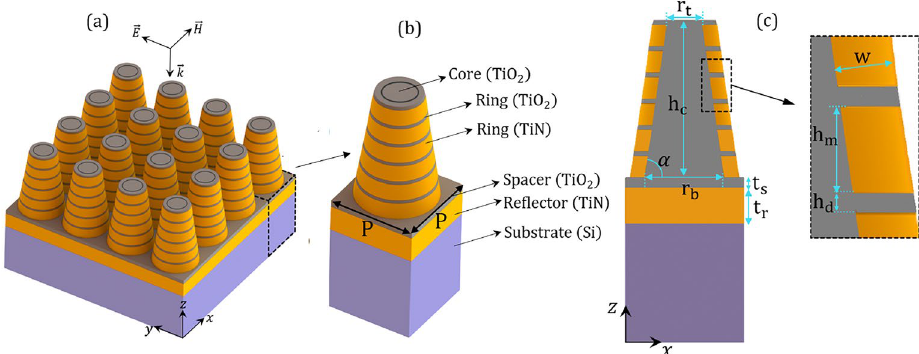
Figure 1. ( a ) Schematic diagram of the proposed metasurface absorber with periodicity P = 500 nm . ( b ) and ( c ) The unit cell and its xz -cross-sectional view. The body of the unit cell is made of a truncated cone-shaped Ti O 2 core of height h c = 660 nm with top and base radii of r t = 101 nm and r b = 200 nm corresponding to the side angle α = 81.47 ◦ . The core is surrounded by conical TiN/Ti O 2 rings of thicknesses W = 30 nm and height h m = 90 nm / h d = 20 nm placed on planar Ti O 2 /TiN layers of thickness t s = 40 nm / t r = 150 nm . The whole array is supported by the Si substrate.